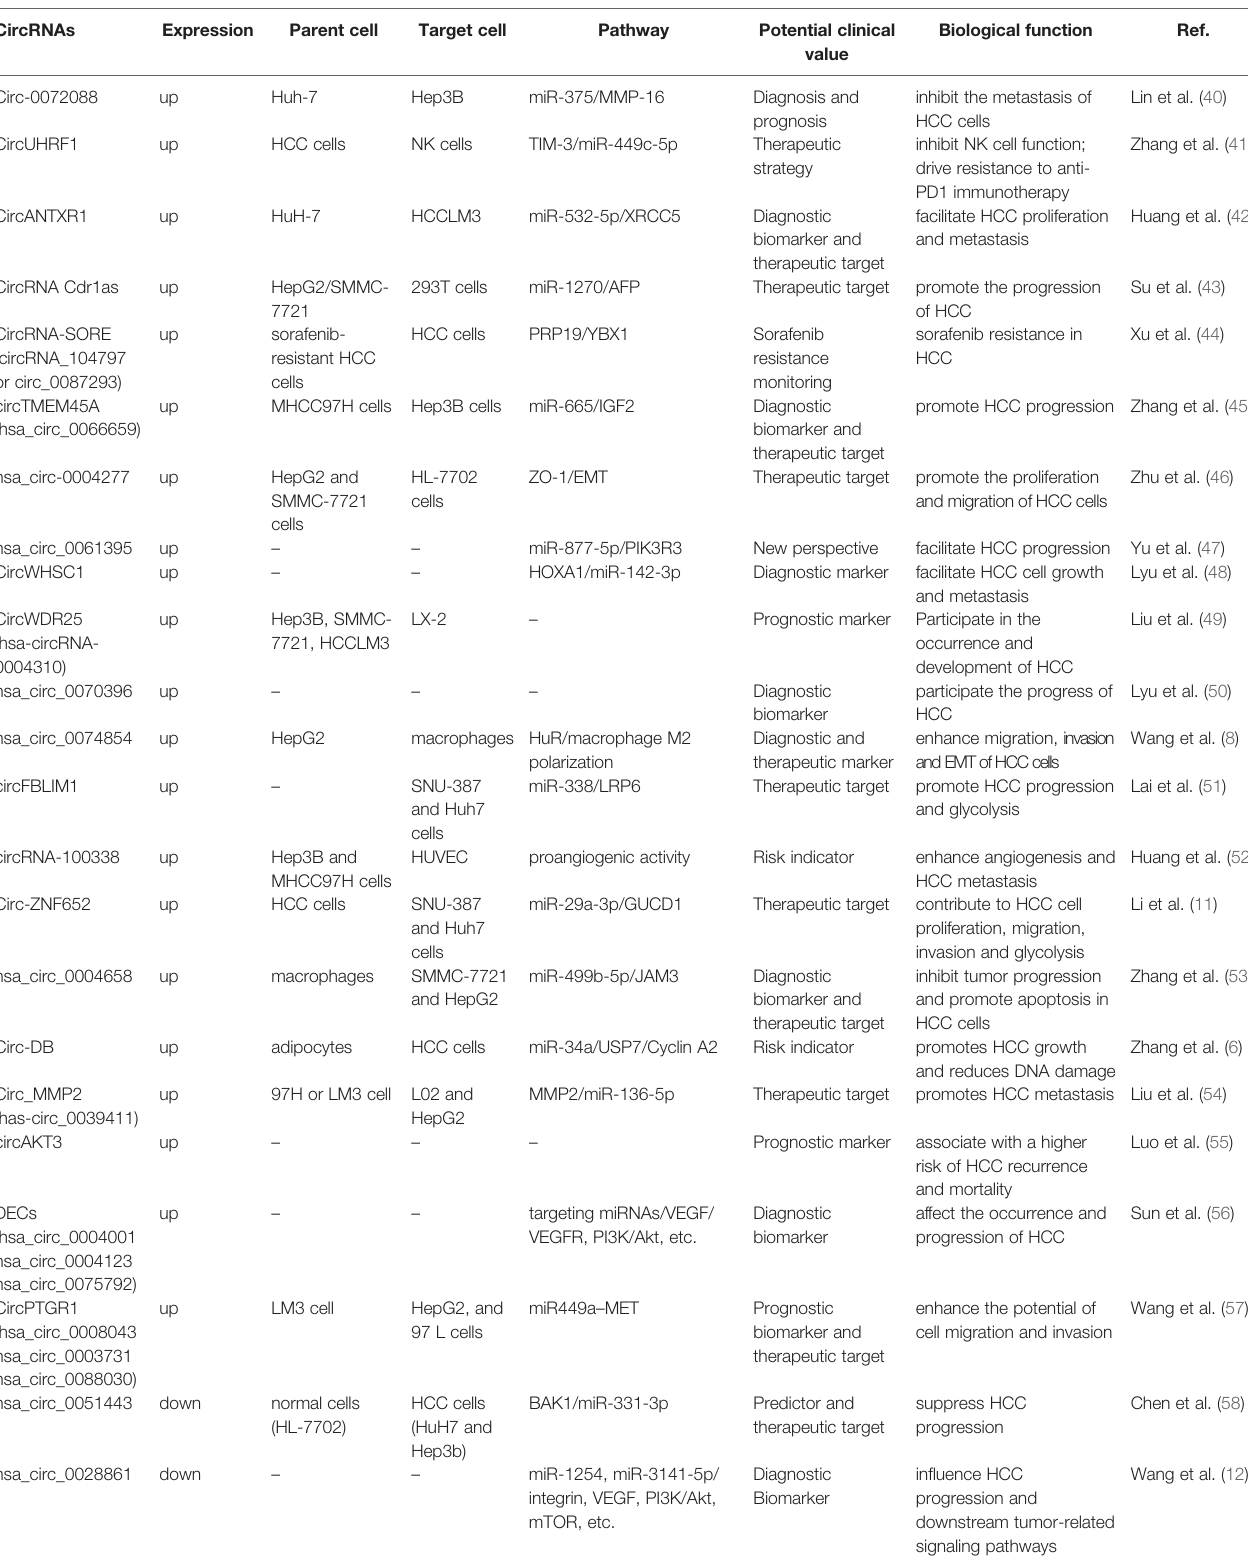
TABLE 1 | The biological functions and potential clinical values of exosomal circular RNAs in